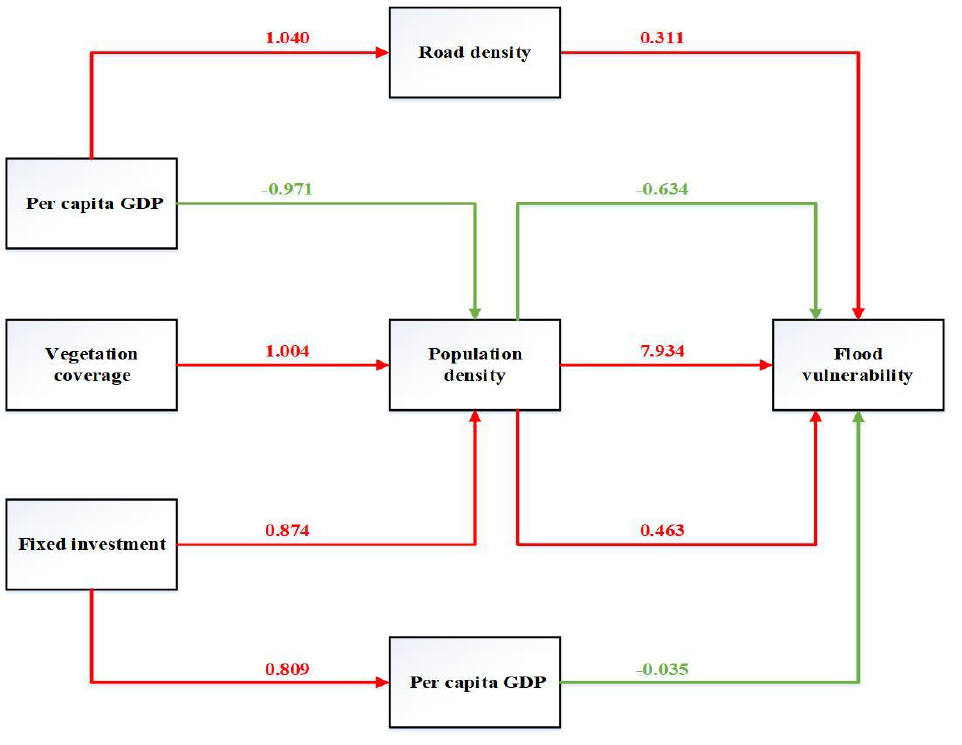
Figure 7. The integrated path models.